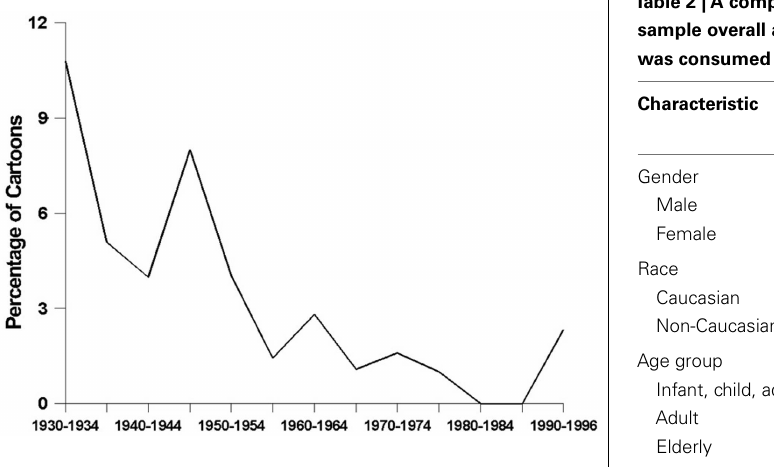
FIGURE 3 |The prevalence of alcohol use among major and minor characters.